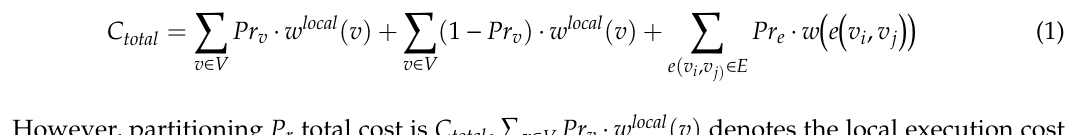
Table 1. Mathematical notation.